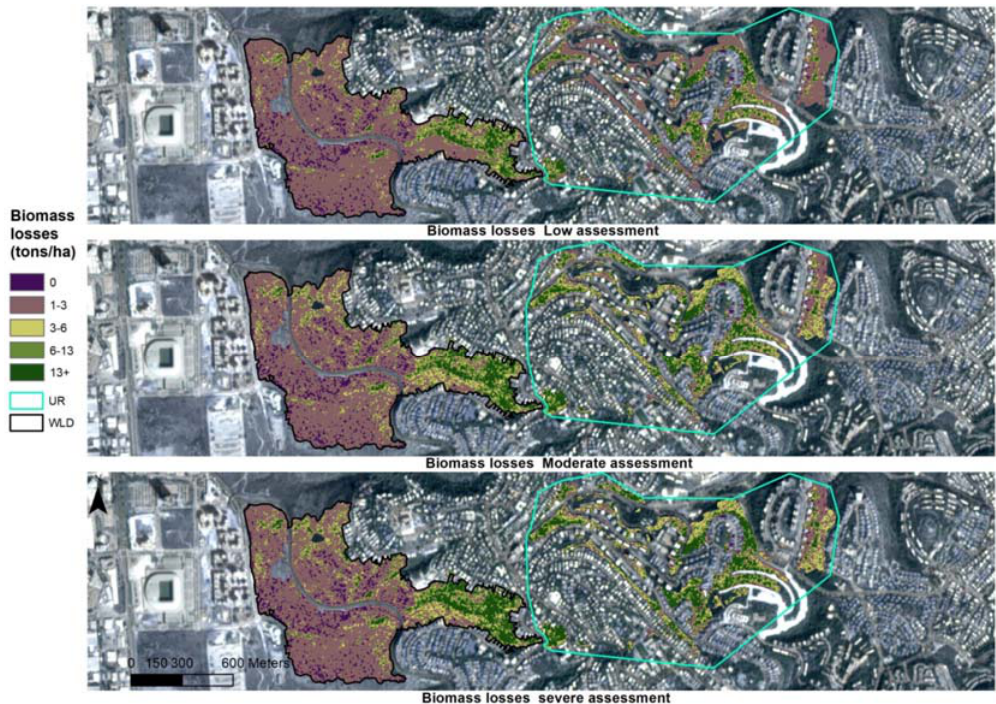
Figure A4. Maps of woody biomass loss derived using different assigned levels of consumed biomass for low, moderate and high burn severity from Meigs et al. [57].